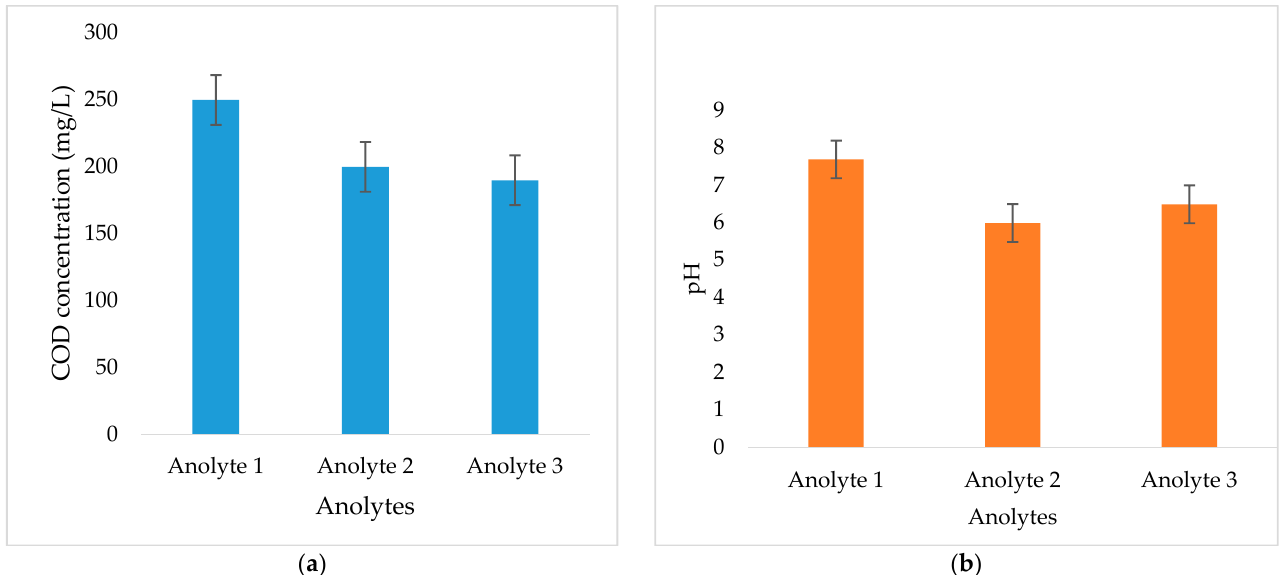
Figure 1. Di ff erences in the used anolytes ( a ) in terms of COD concentration; ( b ) in terms of pH.